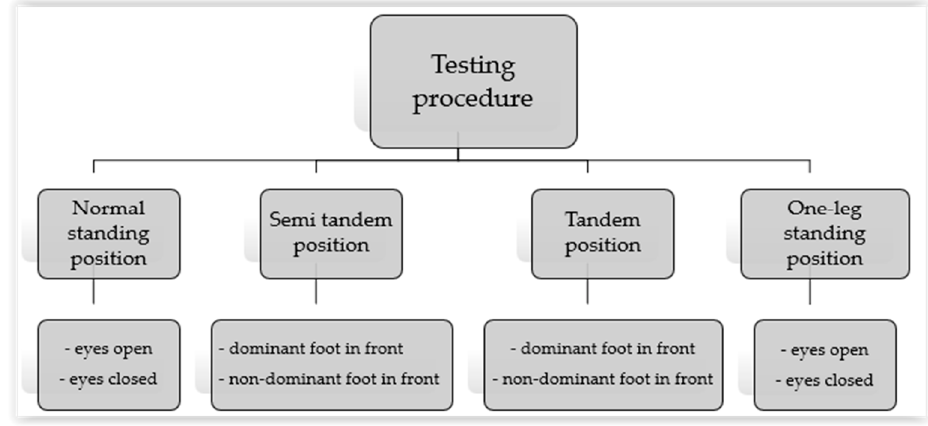
Figure 1. Testing procedures.